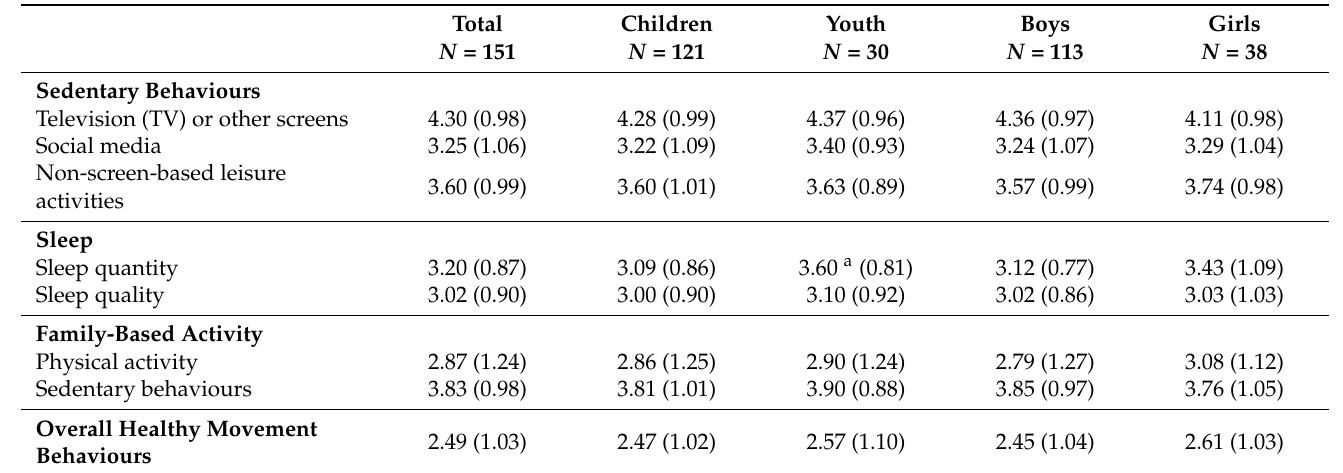
Table 3. Parent-reported changes in movement and play behaviours of children (5–13 years) and youth (14–17 years) during the acute phase (May 2020) of the COVID-19 pandemic ( N = 151). Table 3. Cont.